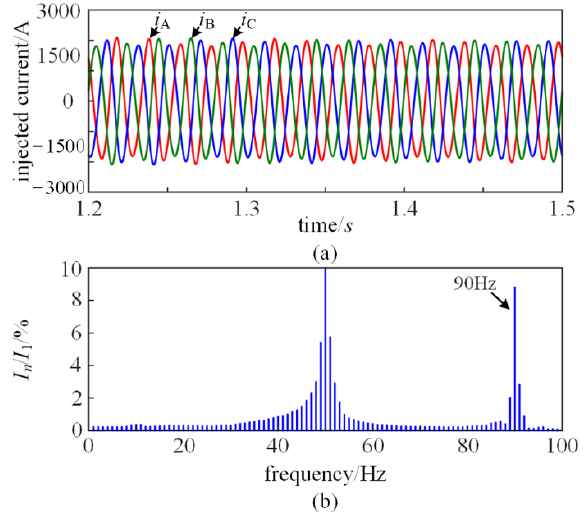
Figure 8. Simulation results of the MMC-HVDC integrated system: ( a ) waveform of injected currents; ( b ) corresponding FFT results of injected currents.